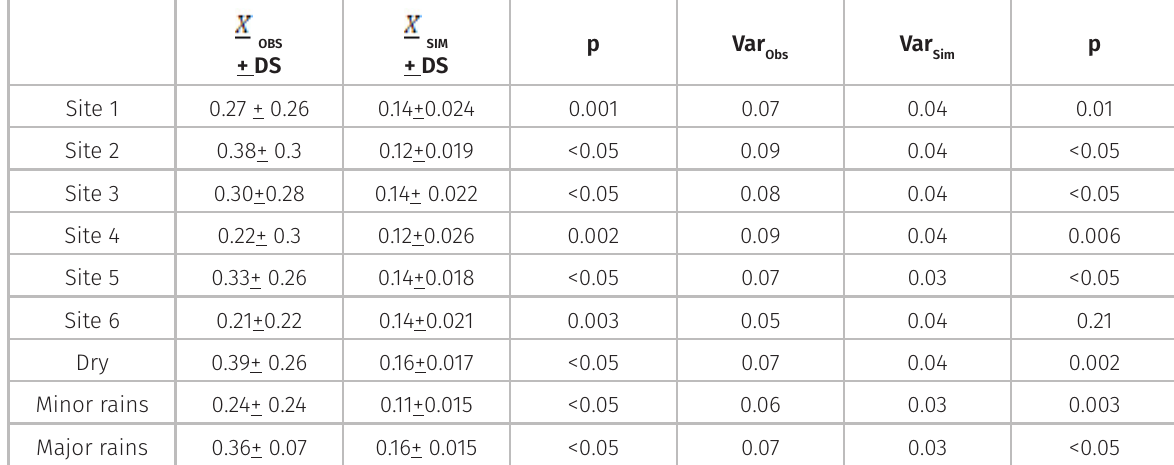
= Observed Mean, X = Simulated Mean, DS = Standard Deviation OBS SIM = Observed variance, Var = Simulated Variance. P = significance Obs Sim